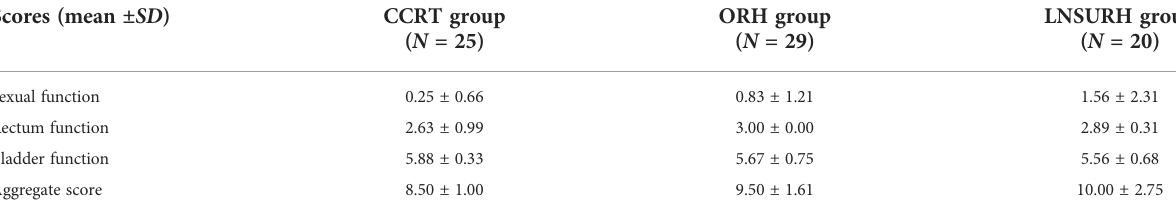
TABLE 3 The scores for each question in the CCRT, ORH, and LNSURH